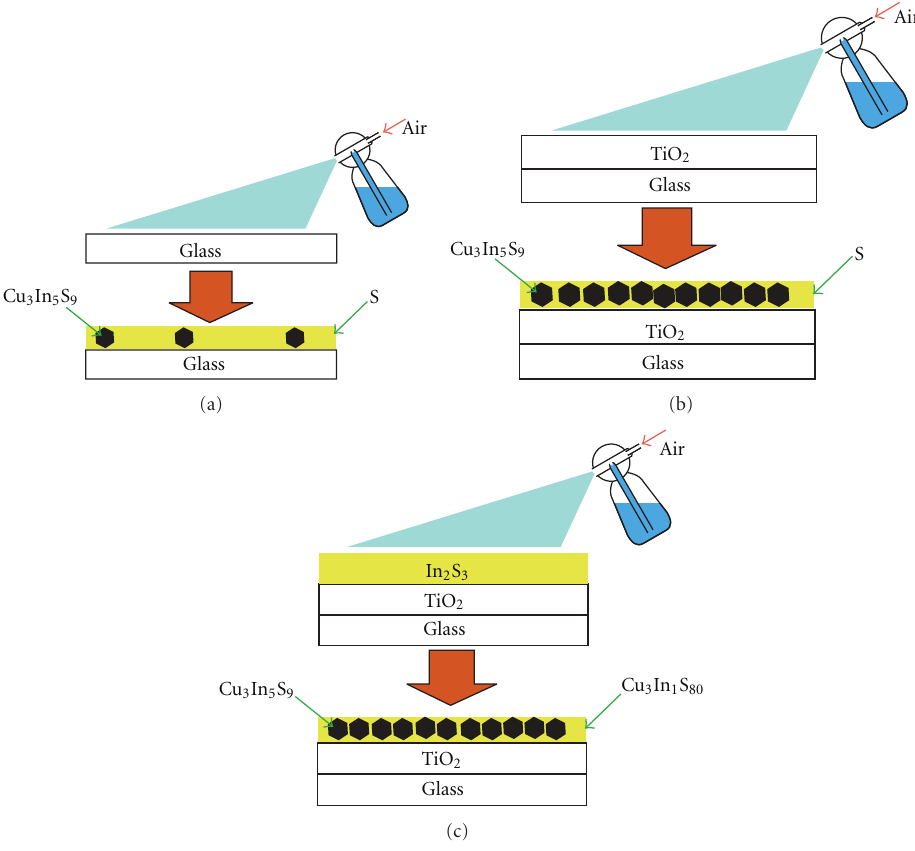
Figure 1: Relations between substrates, (a) glass, (b) glass/TiO 2 , and (c) glass/TiO 2 /In 2 S 3 , and the structures of spray-pyrolysis-deposited